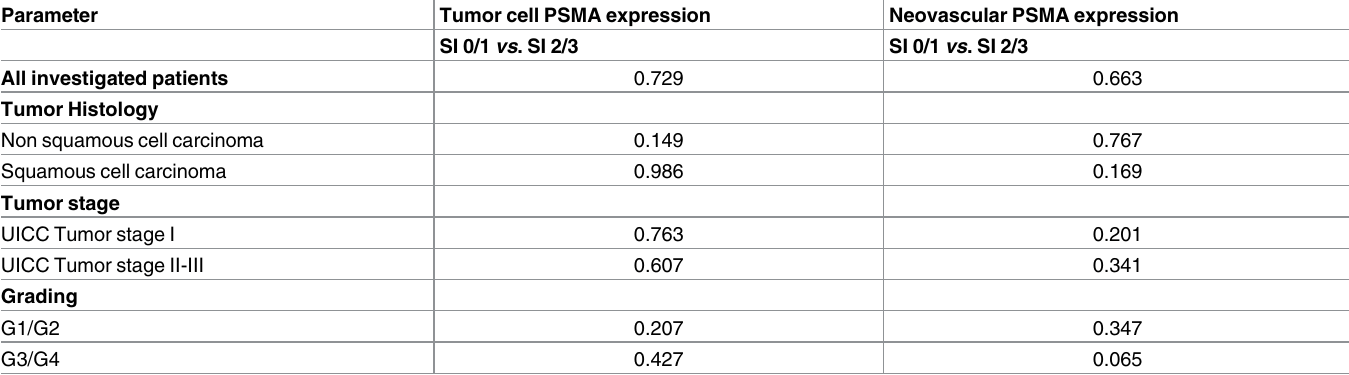
Table 3. Univariate log rank test results for the association of PSMA with overall survival for defined subgroups. The investigatedstudy collective consisted of n = 275 tissue microarray-embeddedNSCLC